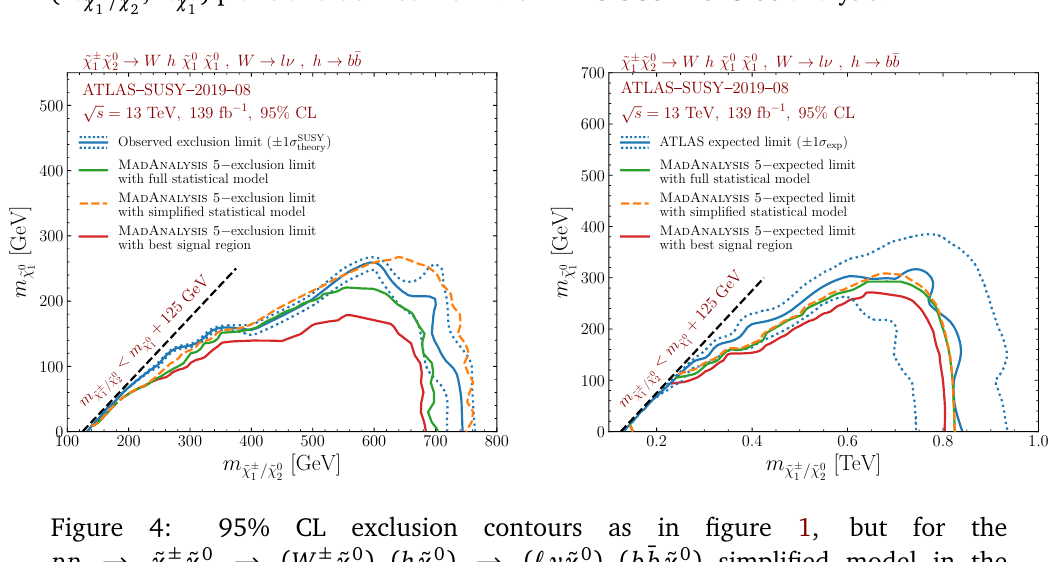
Figure 4: 95% CL exclusion contours as in figure 1, but for the → ( W ± ˜ χ 0 ) ( h ˜ χ 0 ) → ( ℓν ˜ χ 0 ) ( b ¯ b ˜ χ 0 ) simplified model in pp → ˜ χ ± ˜ χ 0 2 1 1 1 1 1